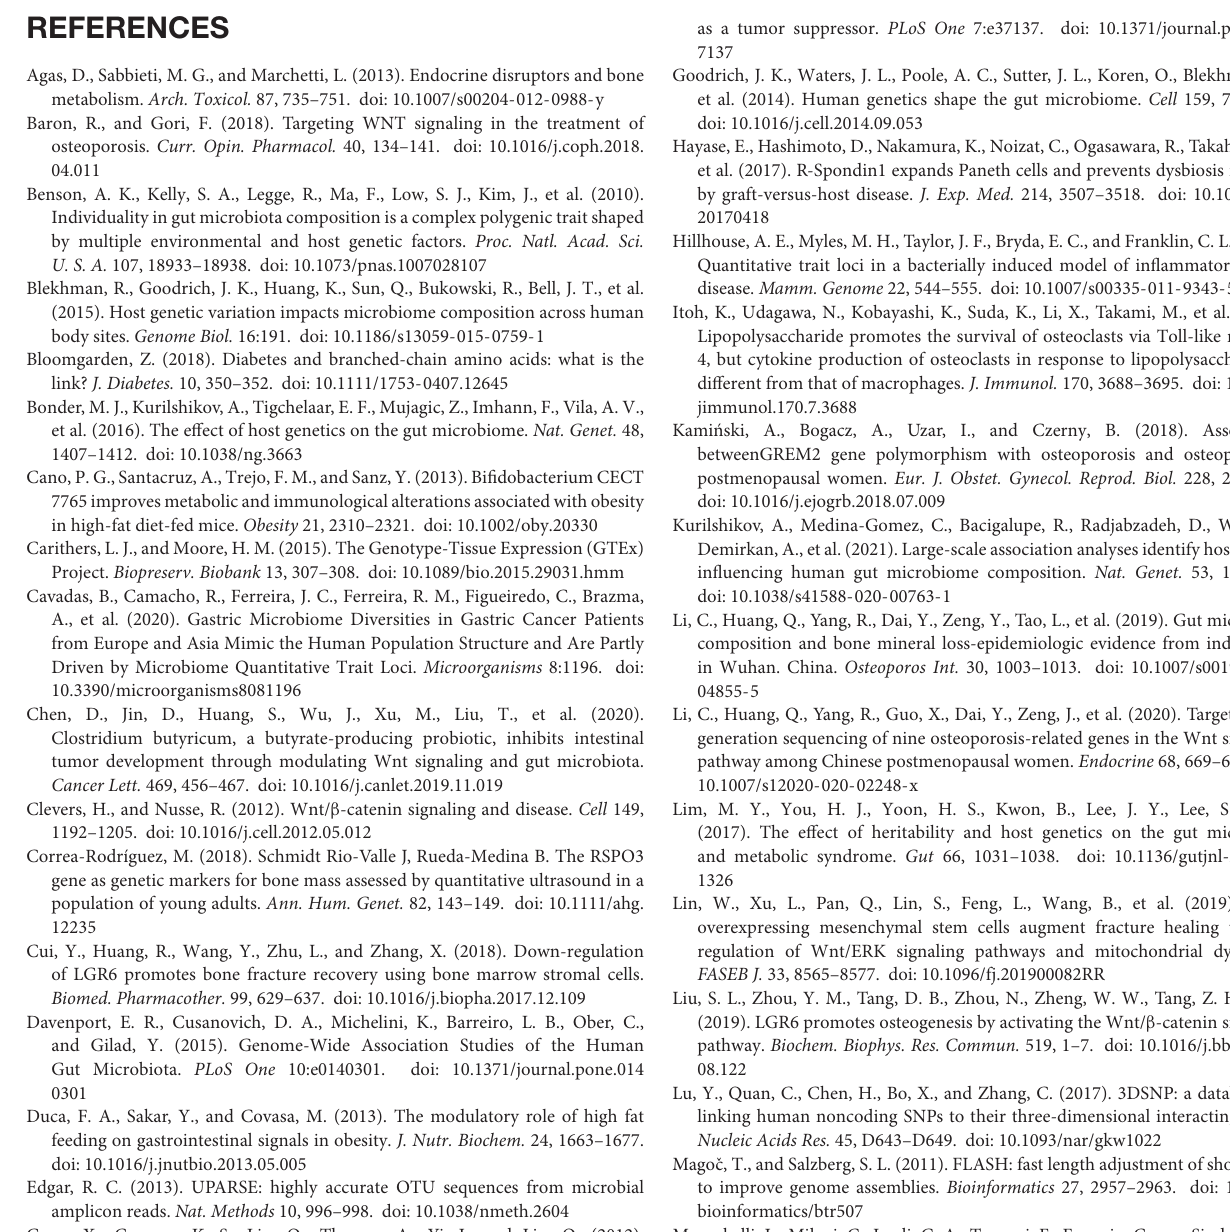
Supplementary Table 4 | Results of the GTEx predictions for the genetic variant of rs10920362 with respect to gene expressions in various tissues. Supplementary Table 5 | Characteristics of included subjects for gut microbiota abundance analysis. Supplementary Table 6 | Bacterial compositions between the case and control groups at different levels. Supplementary Table 7 | Spearman correlation analysis between relative abundance of gut microbiota (at several taxonomic levels) and BMD